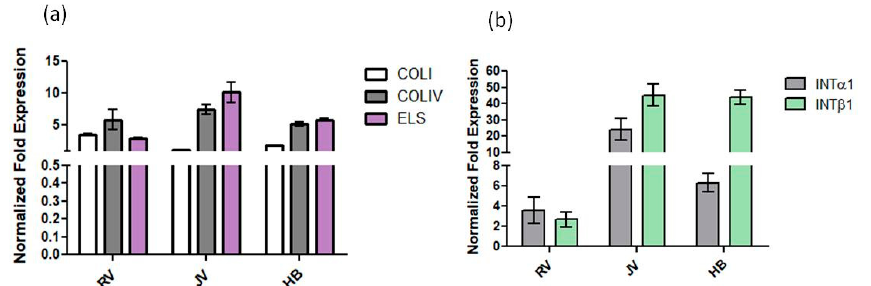
Figure 7. Gene expression analyses: the results are expressed as fold change of HA treated cells respect to untreated cells (CTR) for COLI, COLIV and ELS ( a ) in human dermal fibroblasts. In addition, INT α 1 and β 1 ( b ) were accomplished. Data showed as the averages ±SD.